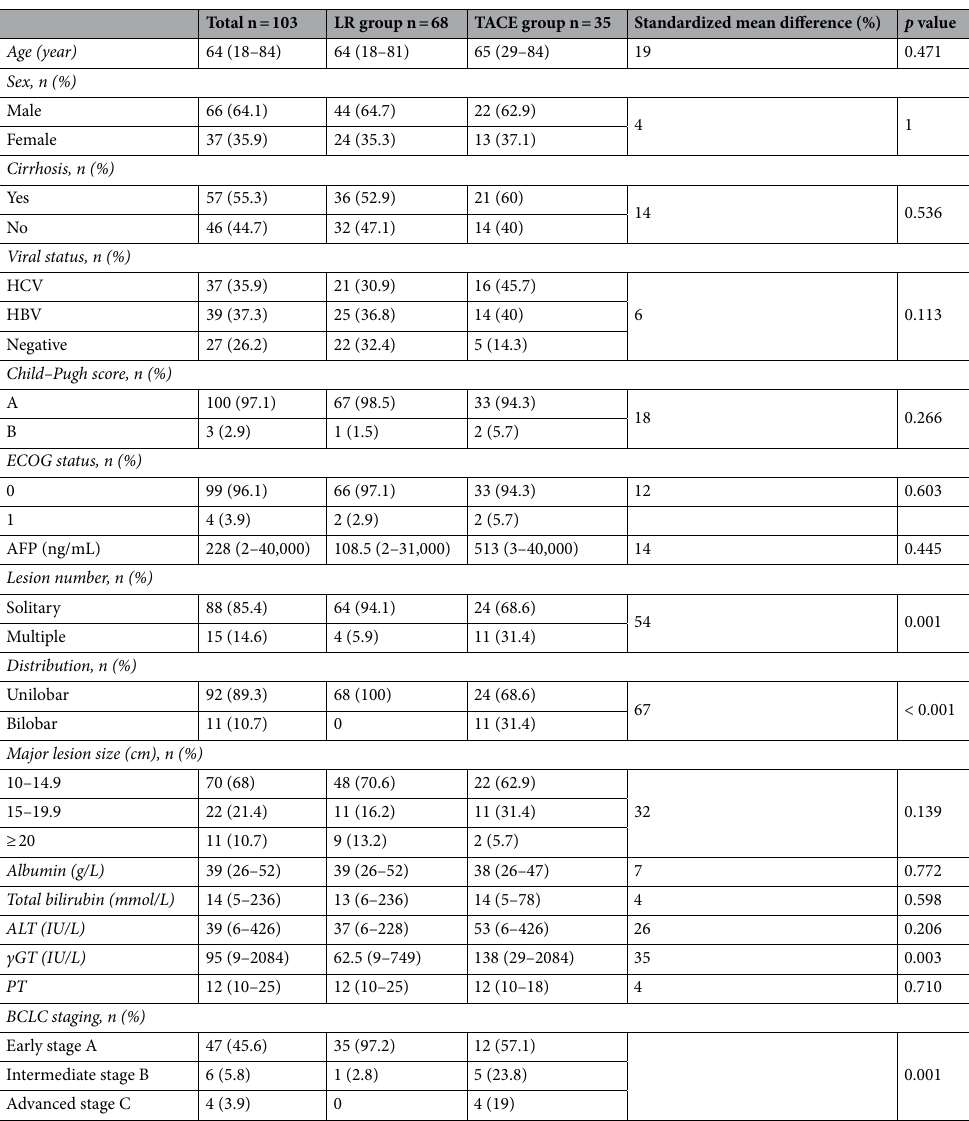
C virus, HBV hepatitis B virus, ECOG Eastern Cooperative Oncology Group, AFP alfa-feto protein, ALT alanine transaminase, γGT γ glutamil transferase, PT prothrombin time, BCLC Barcelona Clinic Liver